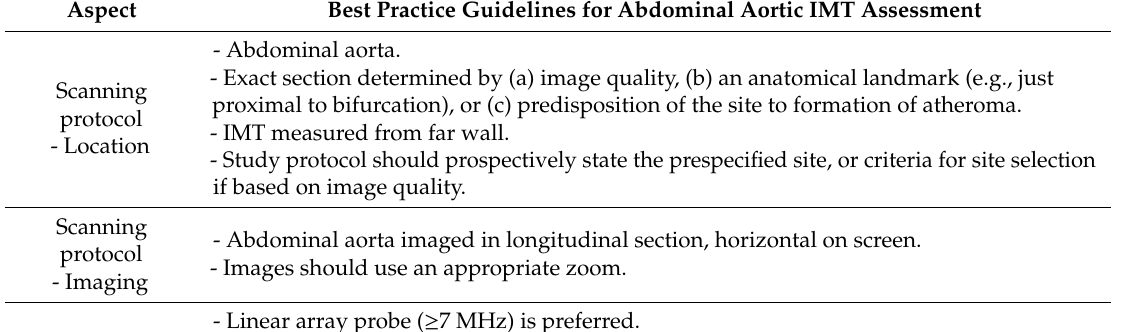
Table A1. Summary of best practice guidelines for abdominal aortic intima-media thickness (IMT).